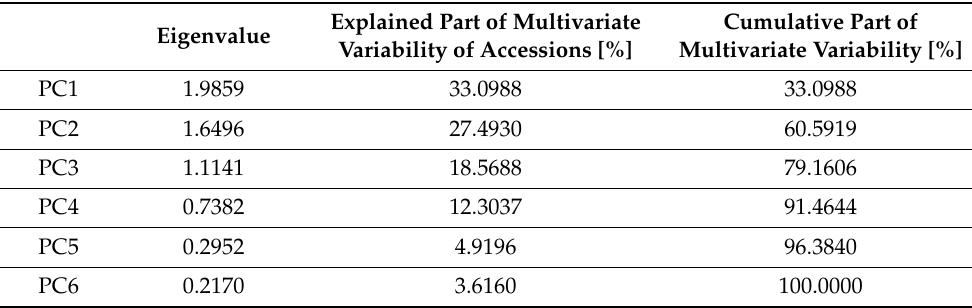
Table 3. Eigenvalues and values of the explained variance for the model from the Aspergillus